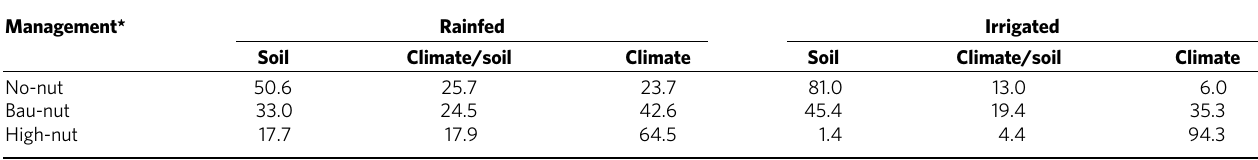
Table 2 | Percentages of grid cells in which yield variability is largest for CV soil , CV dom or not dominated by either one as displayed in Fig.